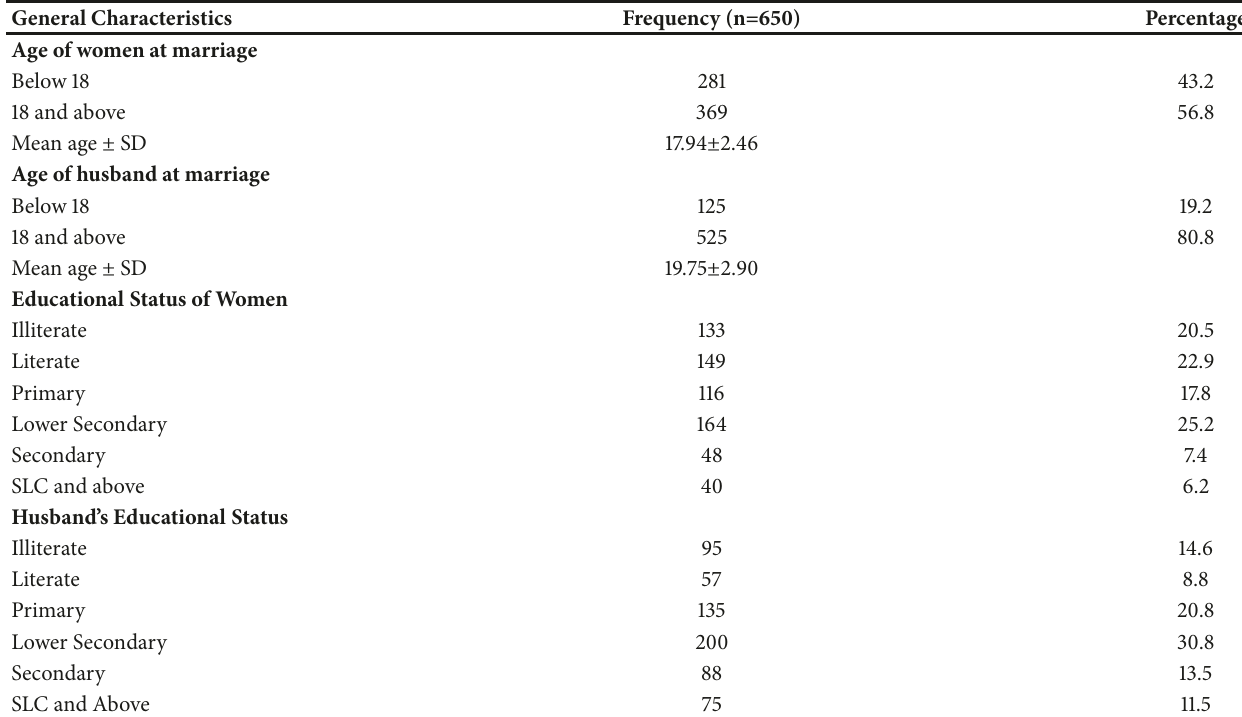
Table 1: Distribution of background related characteristics of study